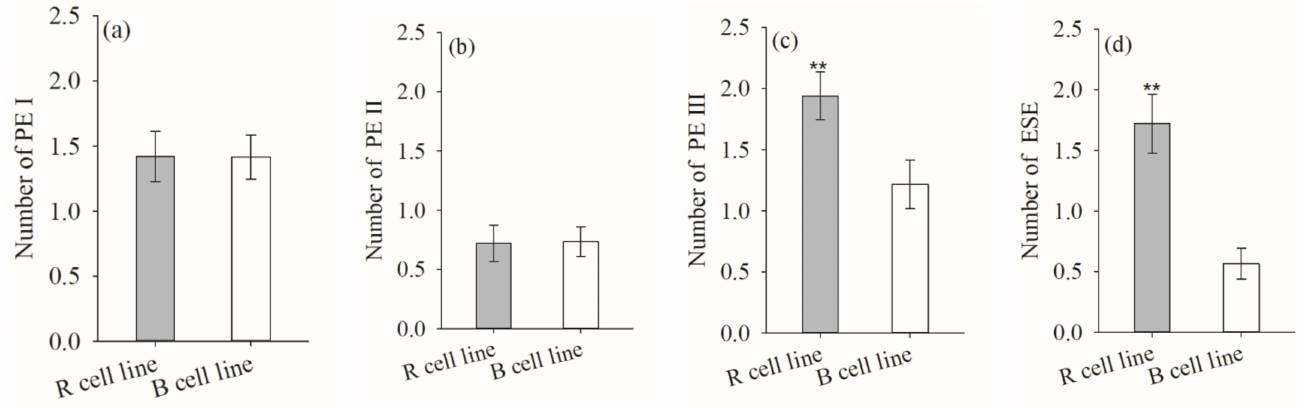
Figure 6. Differences in the numbers of PE I, PE II, PE III, and ESEs between P. koraiensis R and B cell lines. ** indicates that the difference is significant at the p < 0.01 level.